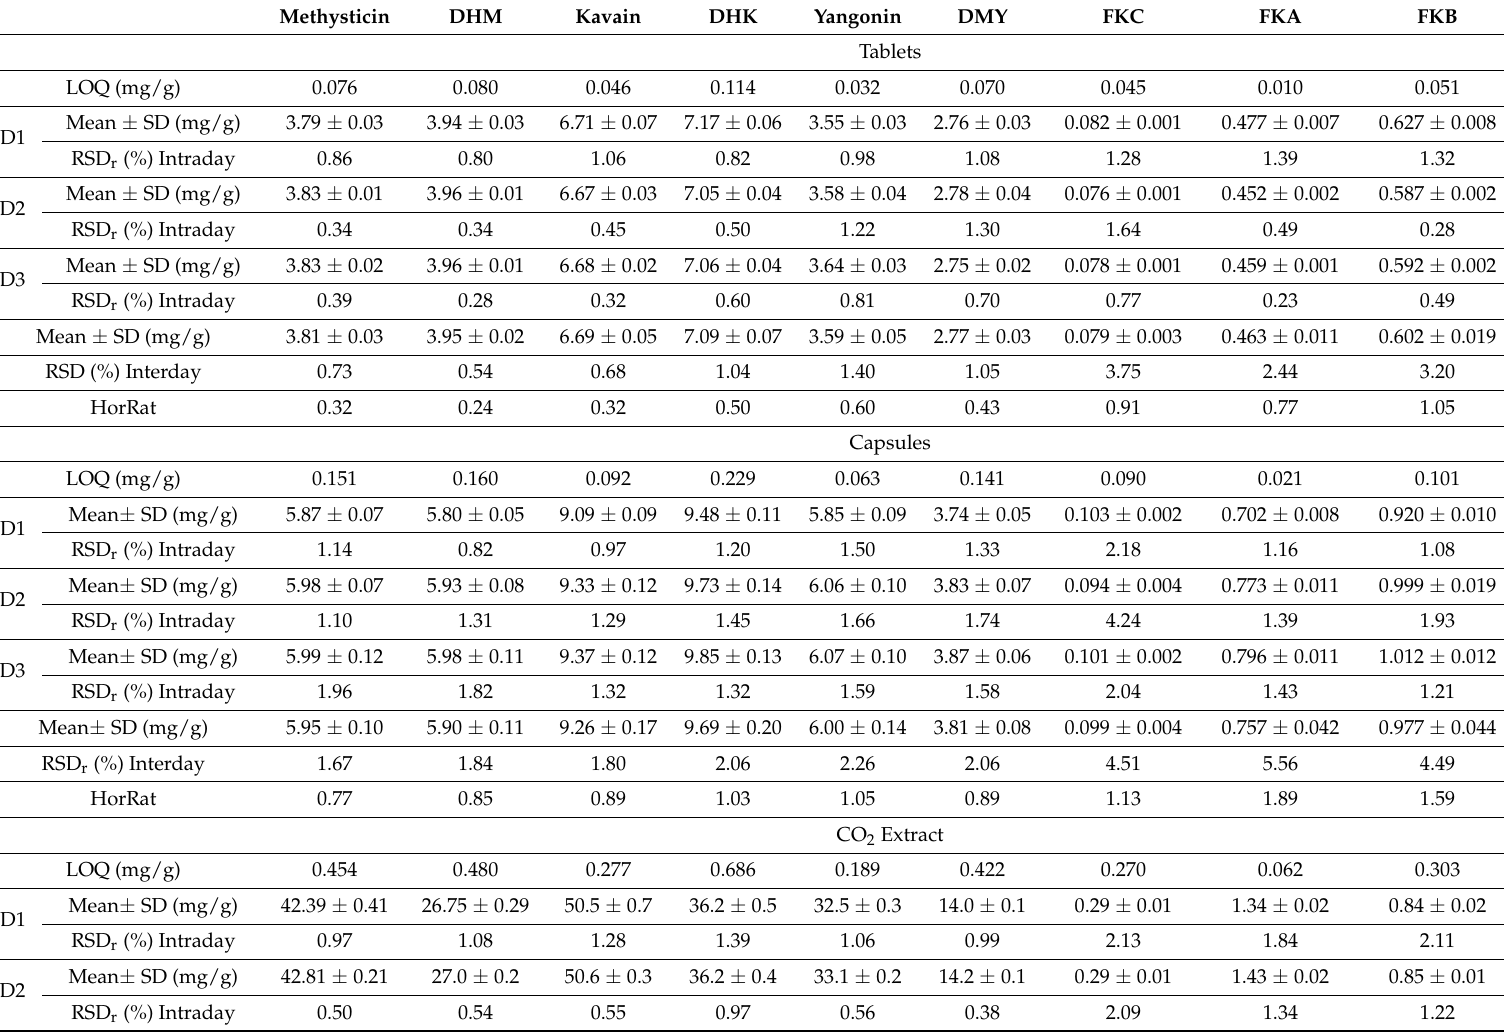
Table 5. Precision summary of the HPLC-UV method for detecting kavalactones and flavokavains in kava